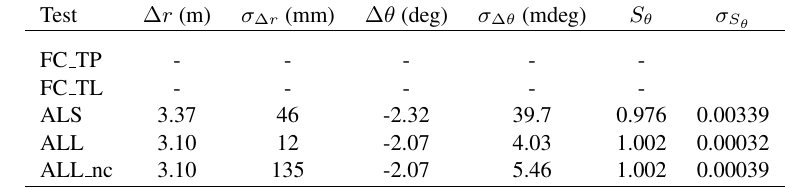
Table 9: Test results: